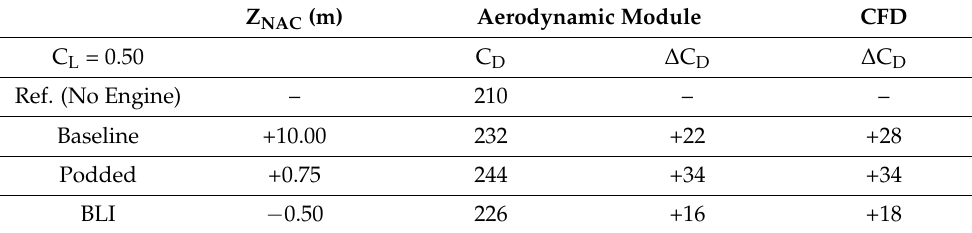
Table 3. NOVA configuration—drag increase (drag counts) for different engine installations.